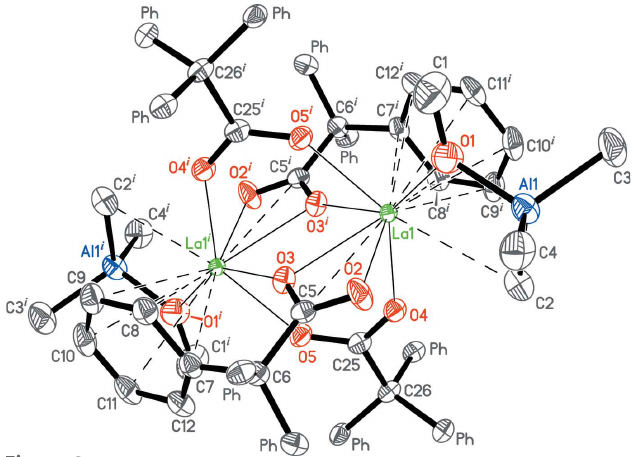
Figure 3 Metal–ligand interactions within the {La(Ph 3 CCOO) 2 (Me 3 AlOMe)} 2 unit. Displacement ellipsoids are drawn at the 50% probability level. Hydrogen atoms are omitted, only C ipso atoms (labeled as Ph) are shown for non-coordinating phenyl groups for clarity. The Ln—C contacts are shown with thin dashed lines. Symmetry code: (i) (cid:3) x , (cid:3) y + 1, (cid:3) z + 1.